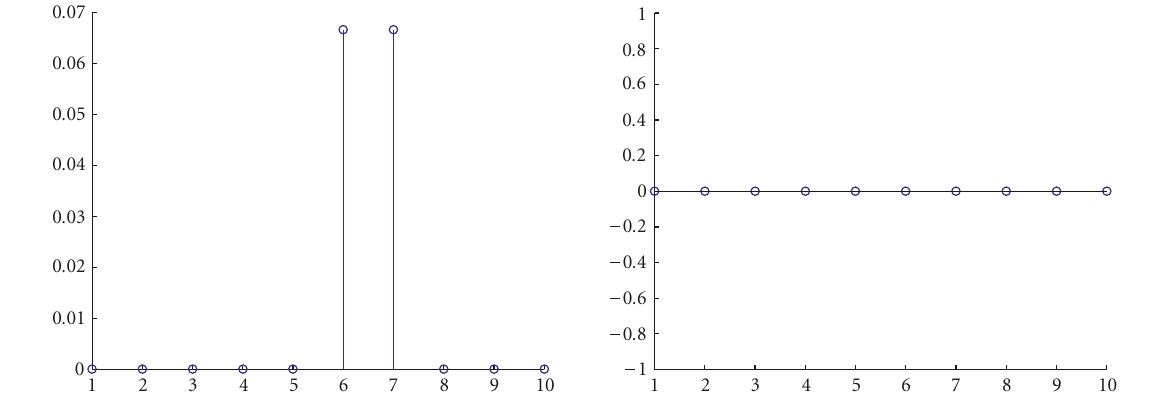
Figure 15: Continuity faults for both architectures.